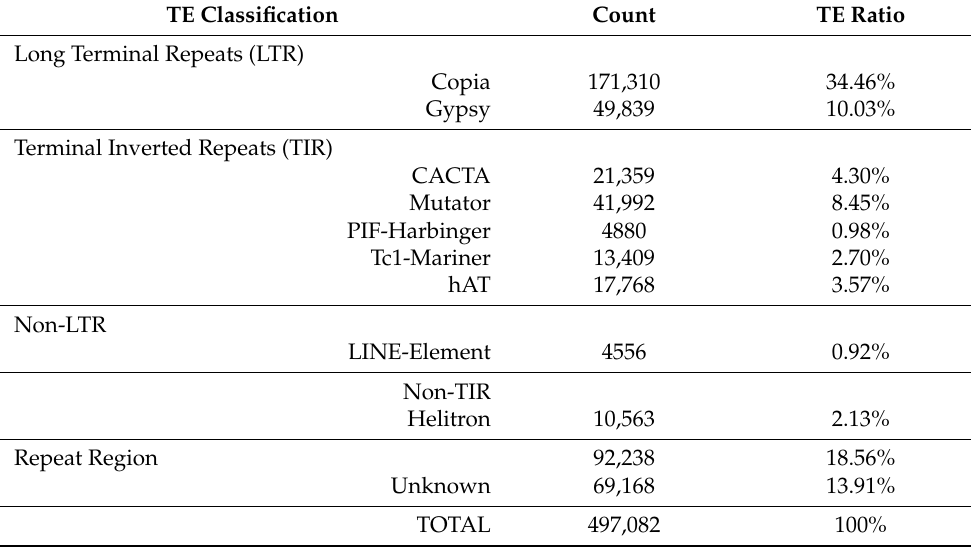
Table 3. Consolidated TE annotation and distribution of abaca var.